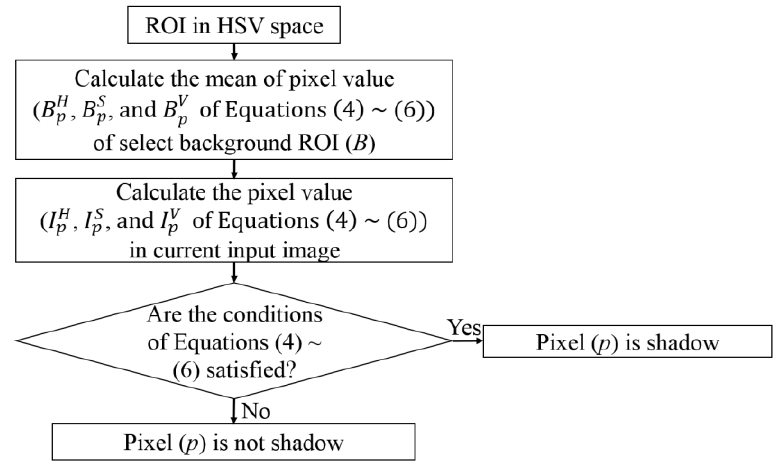
Figure 5. Flowchart for determining shadow for feature 1.